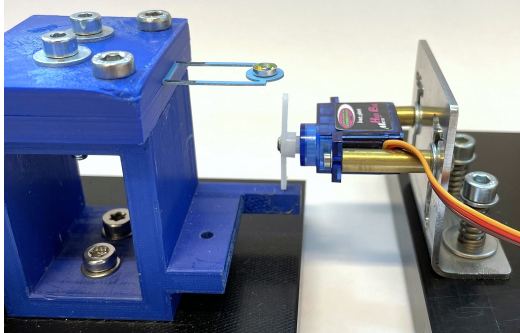
Figure 13. Setup of the piezoresistive measurement with the three- layer sensor